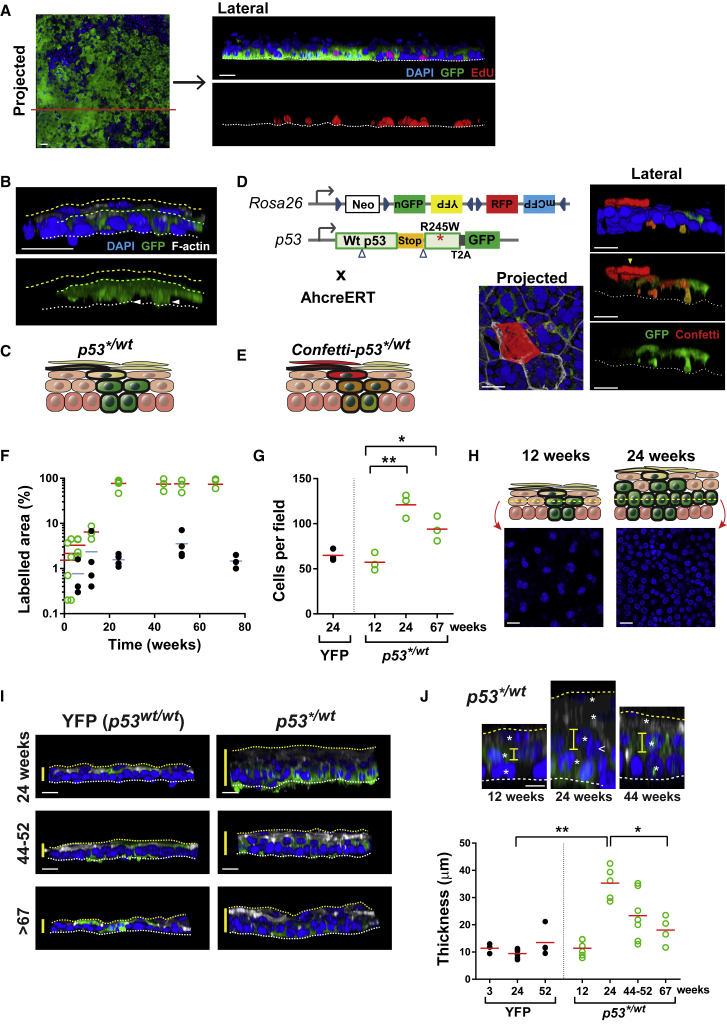
Behavior of Differentiating p53∗/wt Keratinocytes(A) Rendered confocal z stacks showing p53∗/wt clone area. Lateral view shows the section of projected image (red line). White line, basement membrane; blue, DAPI; green, GFP; red, EdU. Scale bars, 20 μm.(B) Side view of p53∗/wt clone at the 12-week time point. White line, basement membrane; yellow line, epidermal surface; green line, outer limit of GFP-expressing cells. Green, GFP; blue, DAPI; white, F-actin. Scale bar, 20 μm, arrowheads, basal layer cells.(C) Schematic: typical p53∗/wt clone with GFP expression (green) confined to basal and first suprabasal cell layers.(D) Multicolor lineage tracing in AhcreERTRosa26flConfetti/wtp53∗/wt animals. Left: the multicolor confetti reporter allele encodes four fluorescent proteins. Different cre-mediated inversion and excision recombination events result in the heritable expression of one of the four fluorescent proteins depicted, nuclear GFP, yellow fluorescent protein (YFP) red fluorescent protein (RFP), or membrane cyan fluorescent protein (CFP). The fate of p53 mutant progenitors can be tracked in double-labeled clones even if the p53 locus becomes inactive in the differentiating progeny. Right: rendered z stacks of typical Confetti-p53∗/wt double-labeled clone 12 weeks post induction of AhcreERTRosa26Confettip53∗/wt mice. Images representative of 8 clones. Yellow arrowhead, cornified cell. Scale bars, 20 μm.(E) Schematic: RFP expression reveals differentiation of p53∗/wt clone.(F) Projected area of labeled epidermis (%) in induced p53∗/wt (open green circles) and p53wt/wtRYFP (solid black circles) mice. Data are from 5 fields per animal. n = 3–5 mice per time point/group. Red and blue lines, mean area for p53∗/wt and p53wt/wtRYFP, respectively.(G) Mean cell density in immediate suprabasal layer. Data are means of 5 fields per mouse. n = 3 mice at each time point/group except 4 fields from 1 animal are shown for YFP. ∗p = 0.0236, ∗∗p = 0.0035 by two-tailed unpaired t test.(H) Single z-slice image of immediate suprabasal layer from p53∗/wt mice at indicated time point. Schematic: typical p53∗/wt colonized area at indicated time point. Scale bar, 20 μm.(I) Rendered confocal z stacks showing side view of epidermal whole mounts. Yellow bars indicate the thickness of epidermis. Green, GFP; blue, DAPI; white, F-actin. Scale bar, 20 μm. White line, basement membrane; yellow line, epidermal surface.(J) Detail analysis of change in epidermal thickness. Top, confocal images (side view) showing changes in p53∗/wt epidermis over time. Yellow bars, length of cells in first suprabasal layer; asterisks, each cell layers. Arrowhead indicates cell in between layers. Scale bar, 20 μm. Bottom, mean thickness of epidermis at time points indicated. n ≥ 3 mice at each time point/group. ∗p = 0.016, ∗∗p = 0.0043 by Mann-Whitney test.See also Figure S6 and Table S2–S4 and S7.